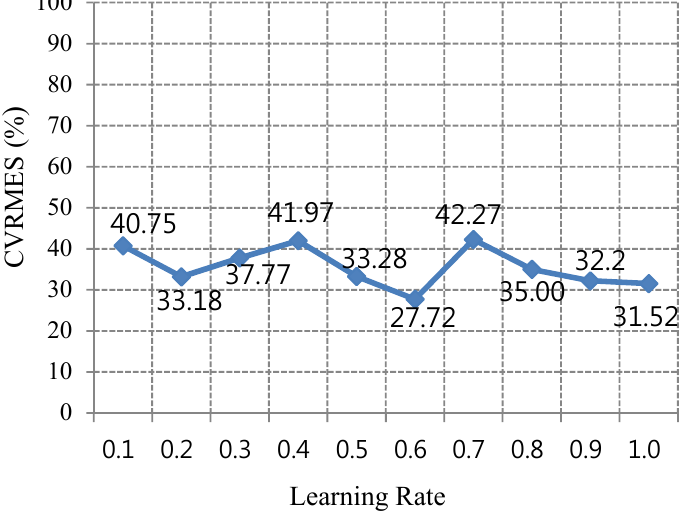
Figure 7. MBE by a different learning